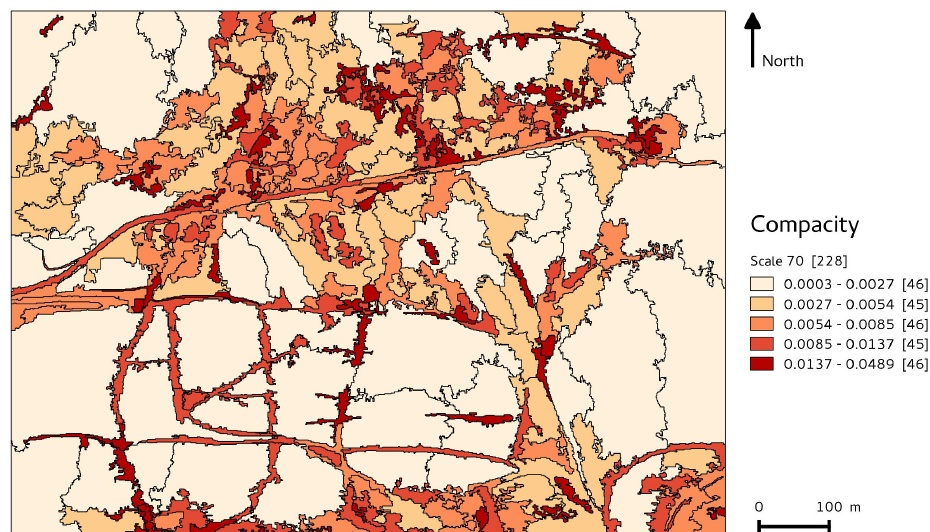
Figure 8. Median of the object compacity; segmentation with Baatz and Schäpe algorithm, at scale 20 providing 228 objects; a quantile classification is used, with the [number of individuals per class].